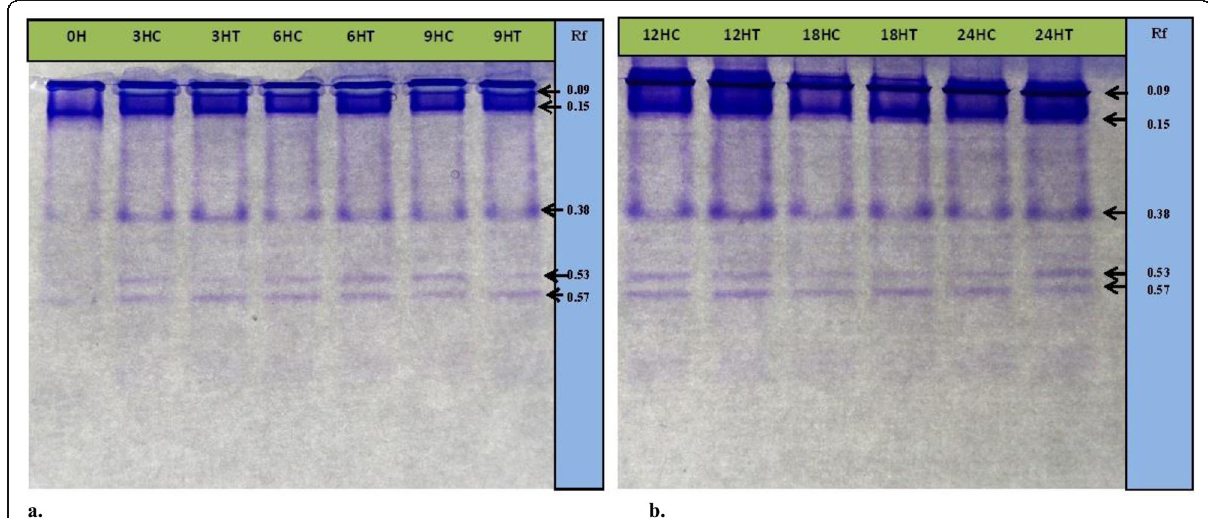
Fig. 3 A comparative electrophoretic profile of plasma fractions of a control (0, 3HC, 6HC, 9HC) and Steinernema abbasi - Xenorhabdus indica infected (3HT, 6HT, 9HT) Helicoverpa armigera , b control (12HC, 18HC, 24HC) and Steinernema abbasi - Xenorhabdus indica infected (12HT, 18HT, 24HT) H. armigera analyzed by NATIVE-PAGE. Gels were analyzed through My Image Analysing Software Version 2.0 (Thermo